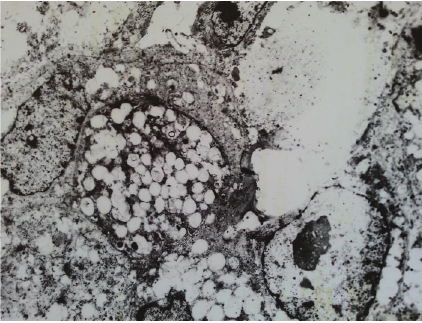
Figure 3: Electron microscopy: lipid-rich carcinoma cells with larger lipid vacuoles as well as with numerous lipid droplets in the cytoplasm.